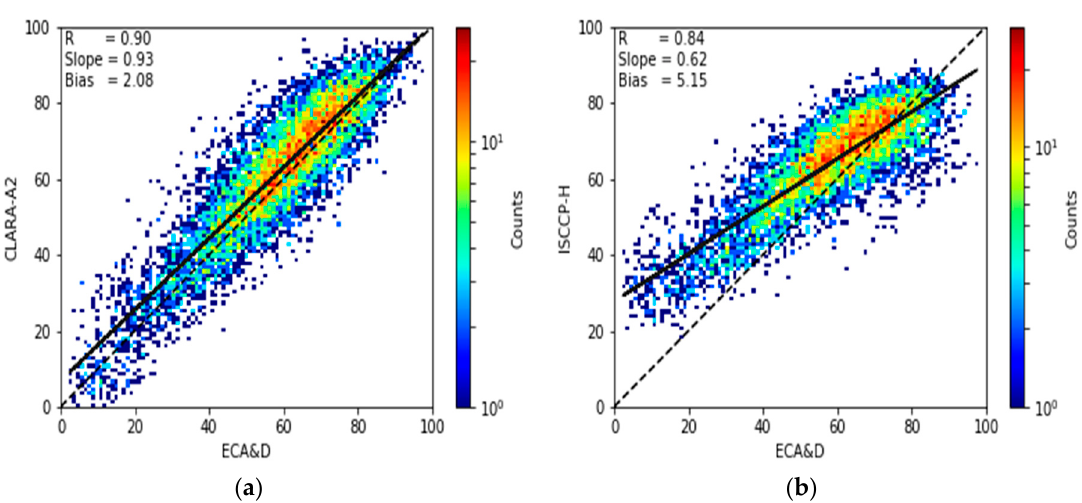
Figure 4. Scatter density plots of monthly mean TCC (%) of ( a ) CLARA-A2 and ( b ) ISCCP-H against all selected ECA&D stations.